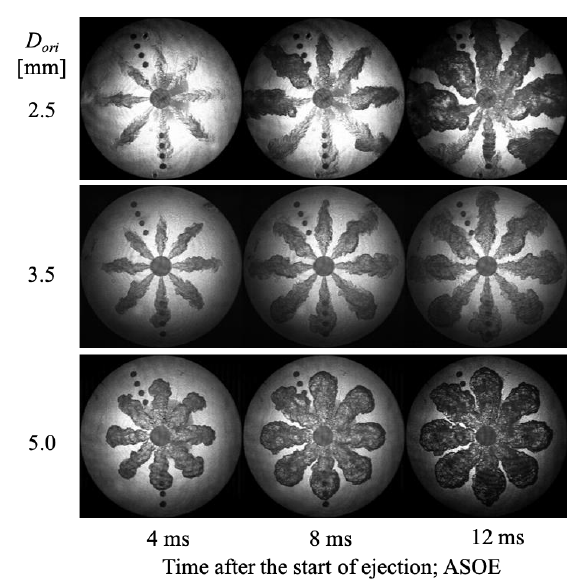
Fig. 17. Shadowgraphs of different orifice diameter (D ori = 2.5, 3.5, 5.0 mm) under “combustible” condition From the shadowgraph images in Fig. 17, the ignition process of MC mixture by the PC torch flames can be dis- cussed in detail. In the case of D = 2.5 mm at 4 ms ASOE, ori half of the torch flames could not ignite the MC mixture, and their ignition delay would be longer than 4 ms